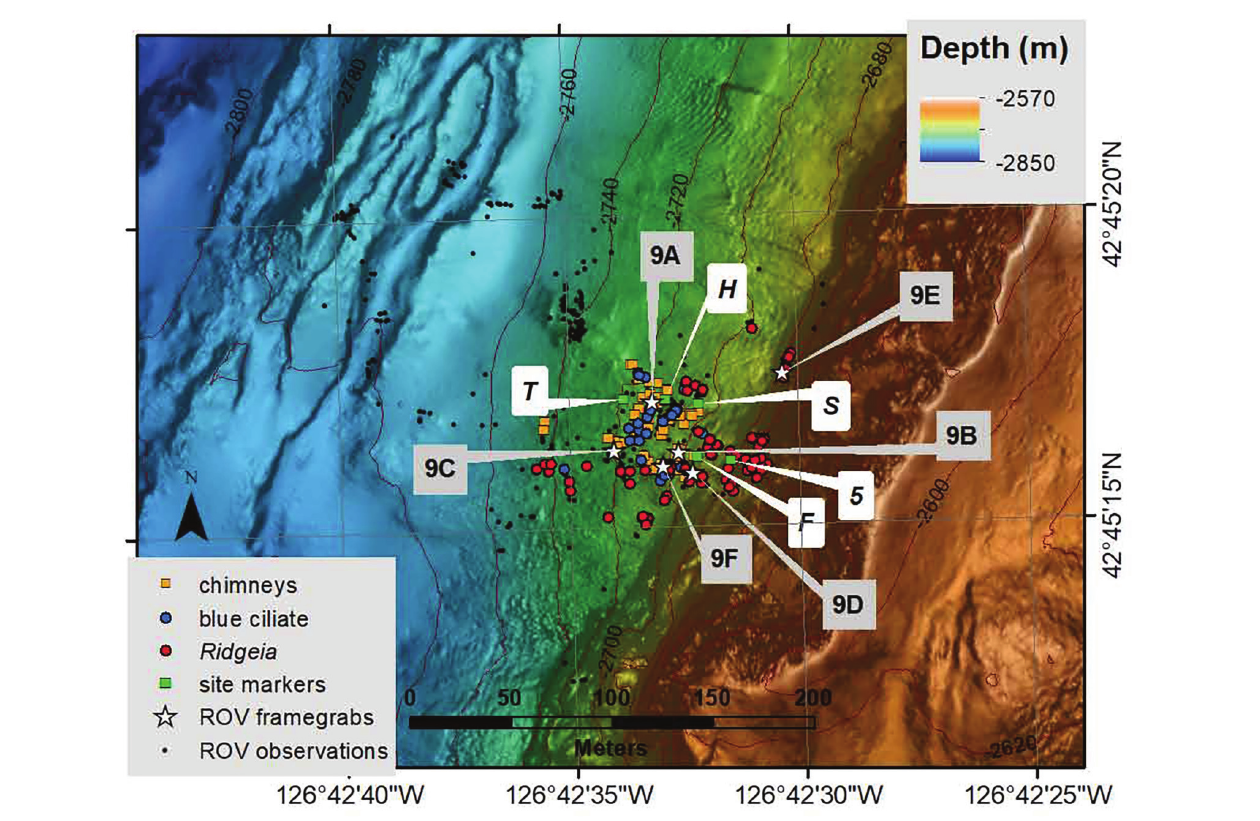
FIGURE 8 | Map of the Sea Cliff hydrothermal site based on dive observations from dive T884 in 2005. All video annotations are shown as small black dots, and observations of Ridgeia piscesae tube worms (red dots), blue ciliate mat (blue dots), hydrothermal chimneys (gold squares), and markers deployed on 2000 and 2002 dives (green squares) shown. The symbols are the location of the ROV when a specific feature was observed in the video, so a single feature can result in multiple observations. Locations of video framegrabs in Figure 9 are labeled, as are site markers. The S “marker” is two Sea Cliff submersible steel plate dive weights located about 2 m apart. The cluster of video annotations on the –2740 m contour are an area with abundant brooding